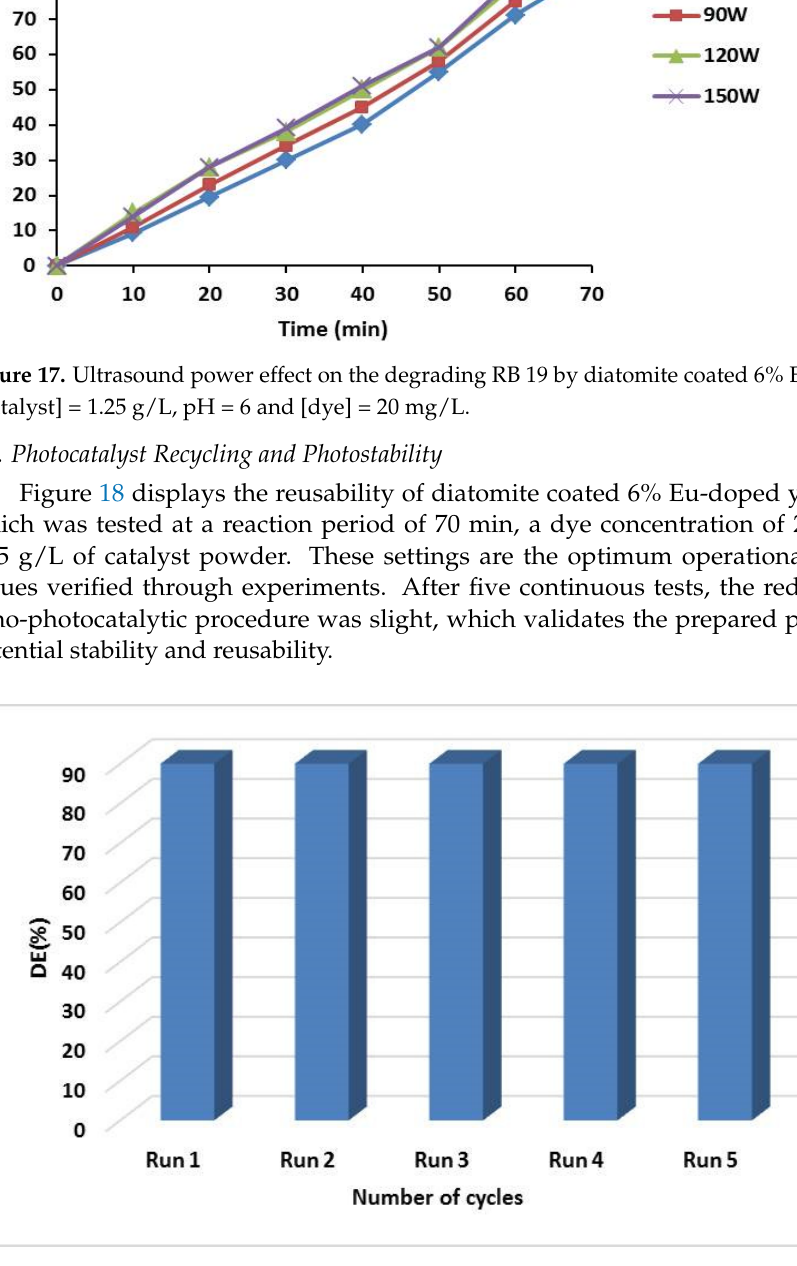
Figure 18. Reusability of the diatomite coated 6% Eu-doped yttrium oxide nanostructures within five runs. [Catalyst] = 1.25 g/L, [dye] = 20 mg/L, pH = 6 and the reaction time = 70